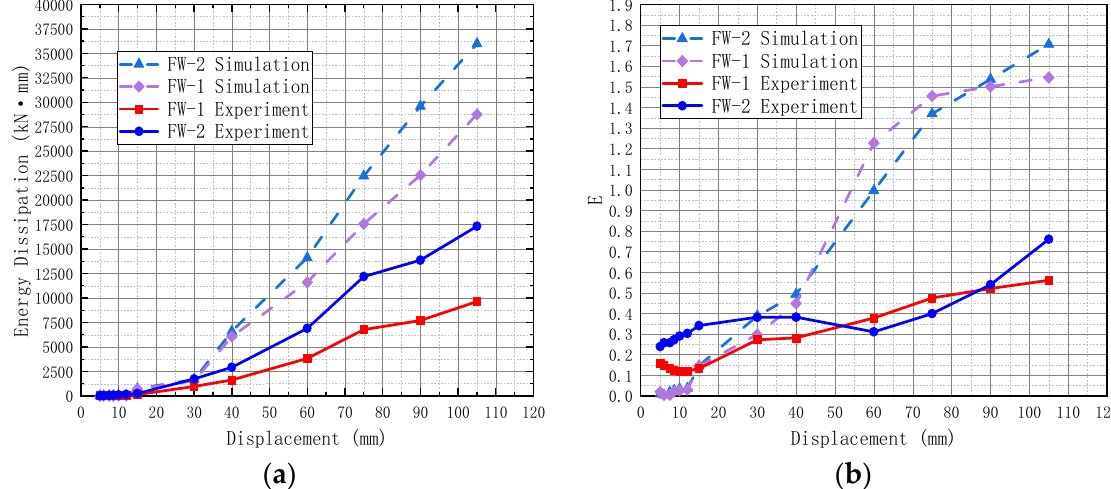
Figure 23. Energy dissipation comparison of FW-1 and FW-2: ( a ) Energy dissipation; ( b ) Energy dissipation coefficient.